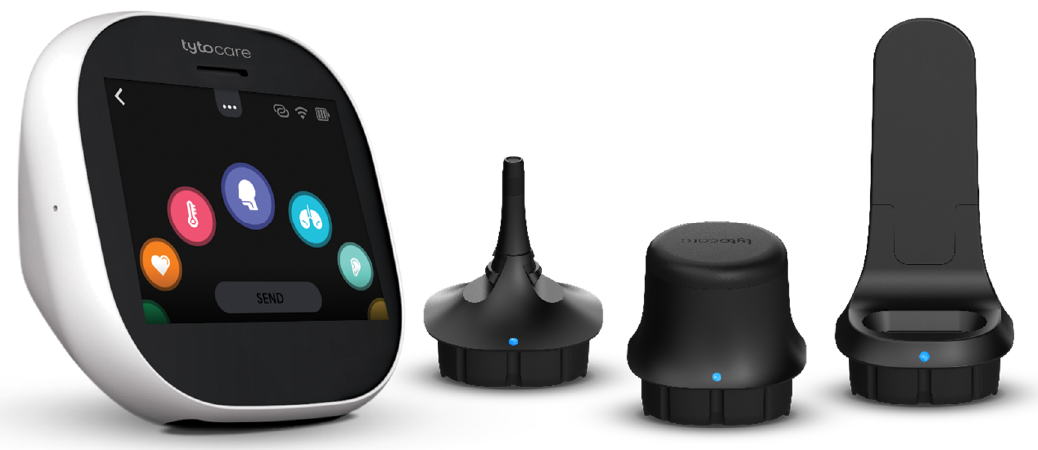
Figure 1. The TytoCare ® System.